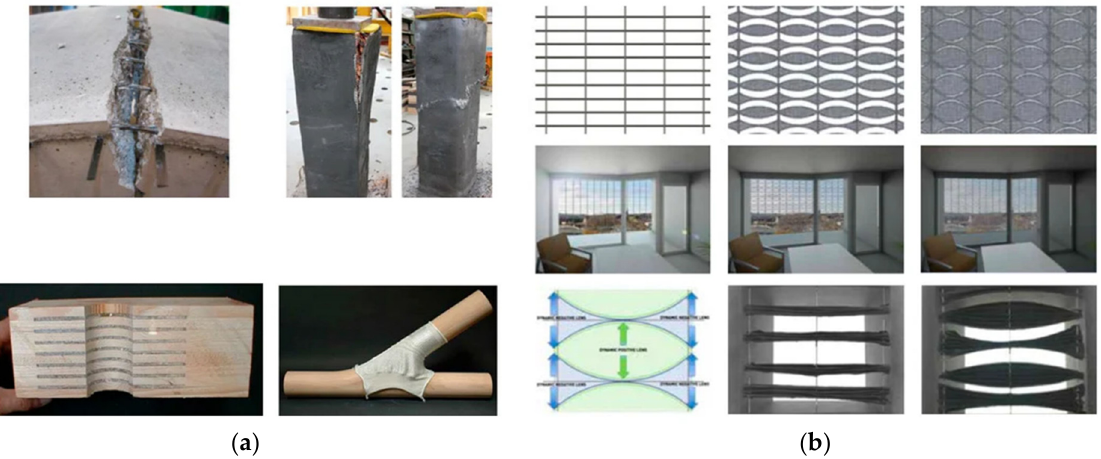
Figure 1. Examples of textiles and smart textiles: ( a ) construction retrofit; ( b ) smart shading. Figures reproduced from [3] under the terms and conditions of a Creative Commons CC-BY license agreement.